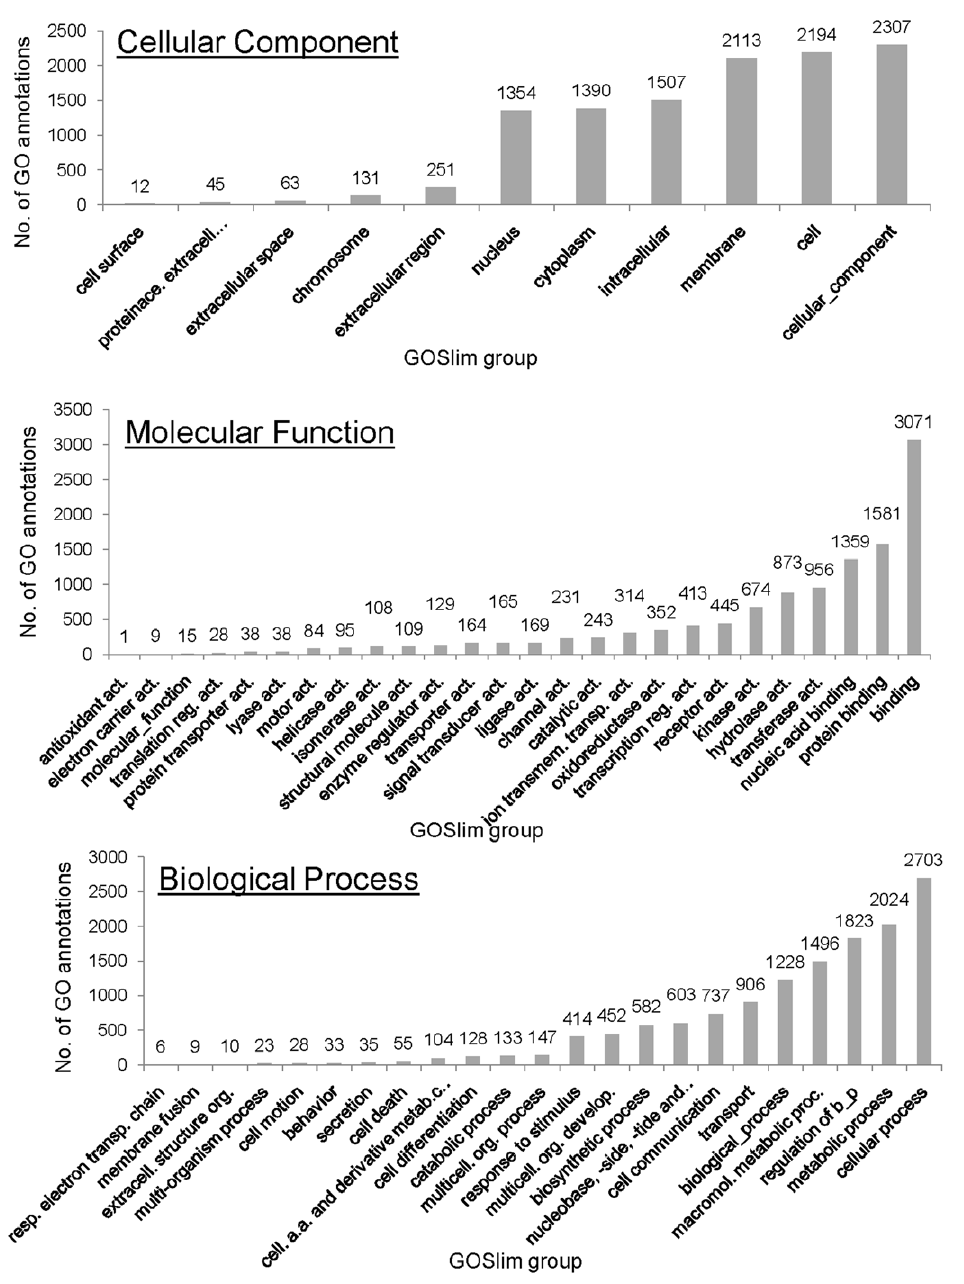
Figure 1. Whole microarray GOSlim modelling. The difference in number of GO annotations in the GOSlim groups for the GO ontologies ‘cellular component’, ‘molecular function’ and ‘biological process’ between the original and re-annotated whole microarray gene dataset. The whole microarray GOSlim modeling shows that re-annotation increases the number of GO annotations in each GOSlim group for each ontology. doi:10.1371/journal.pone.0010642.g001 pathways identified in the original (Table 3) and re-annotated (Table 4) whole array datasets. Only two out of ten pathways are shared (indicated in bold). The mean pathway coverage ratio for the pathways (i.e. number of genes in datasets/total number of genes in pathway) represented for the original annotations is 0.090 but for the re-annotated data is 0.445 (i.e. 5-fold increase). We identified 34 pathways shared between the original and re- annotated differentially expressed mRNA datasets. Similar to the whole array, the pathway coverage in the re-annotated dataset was mean coverage of 25.4%. Table 3 and 4 lists the top 10 significant increased 6.3-fold, with a coverage variance of 61% of the original